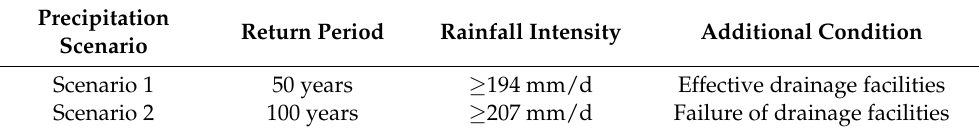
Table 5. Description of two precipitation scenarios.